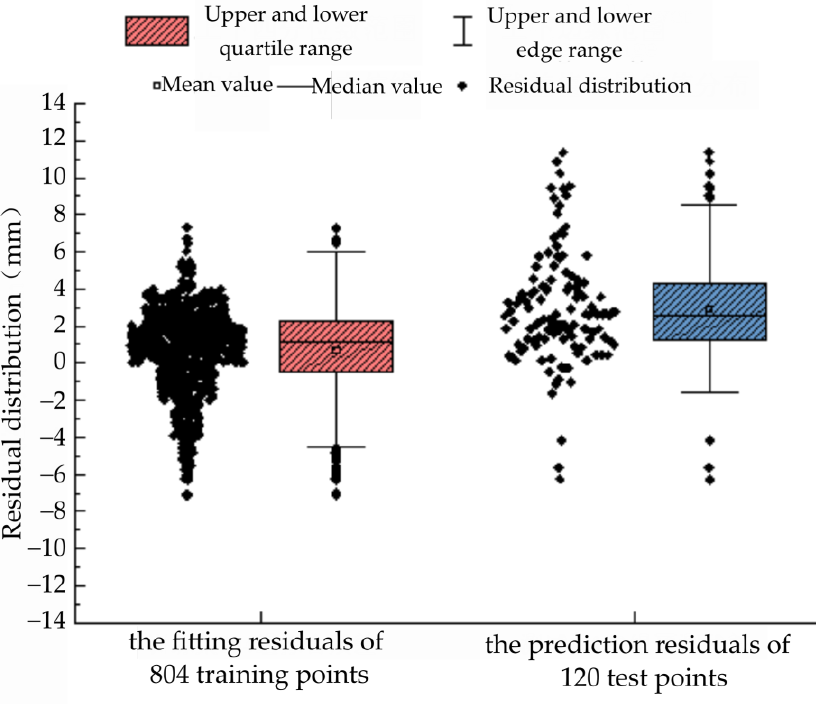
Figure 3. Box chart of model fitting and prediction residuals. Table 4. Settlement fitting and prediction performance analysis of new multiple points monitoring model.